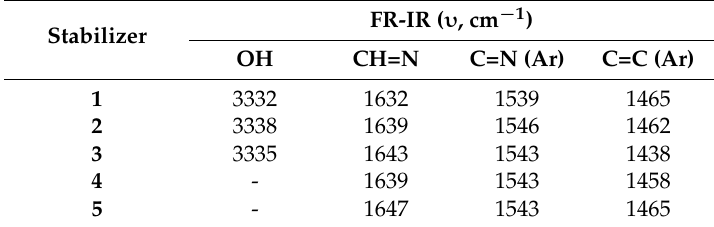
Table 2. Some Fourier transform infrared (FTIR) spectral data for Schiff bases 1 – 5 .